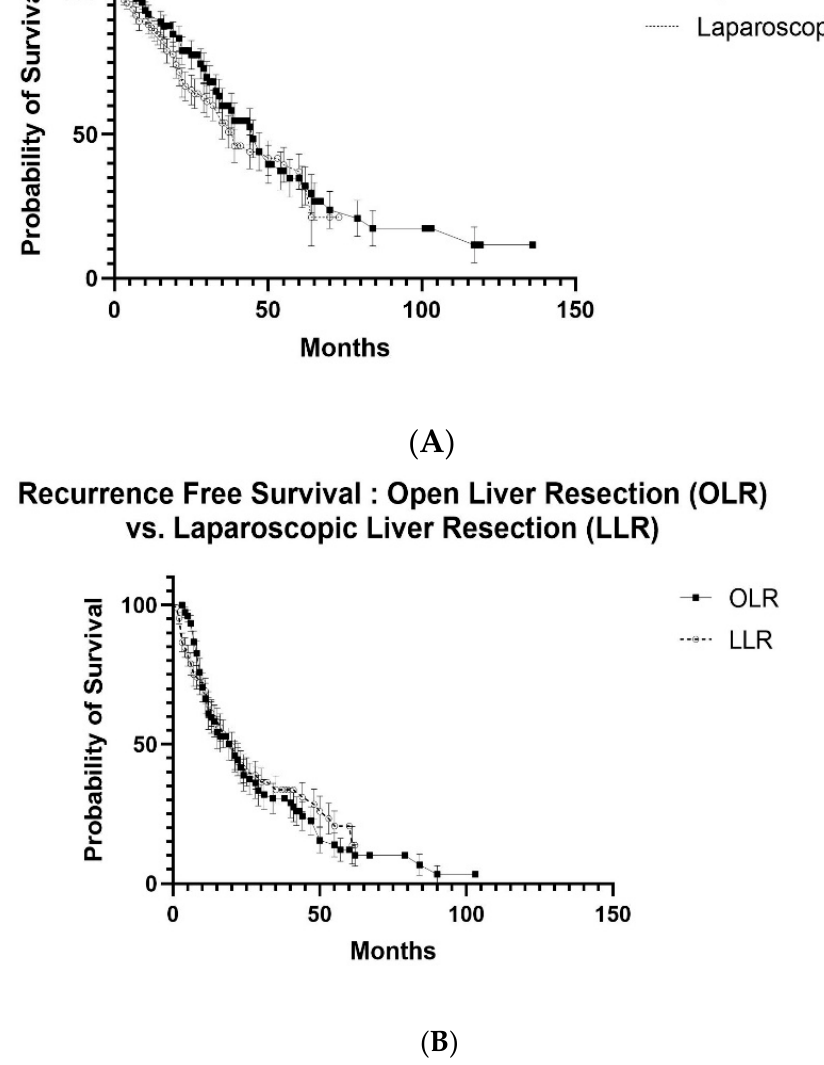
Figure 1. ( A ) Overall survival curves for open liver resection (OLR) vs. laparoscopic liver resection (LLR) after propensity score matching (PSM) for colorectal liver metastases (CRLMs), ( B ) recurrence-free survival curves for open liver resection (OLR) vs. laparoscopic liver resection (LLR) after propensity score matching (PSM) for colorectal liver metastases (CRLM).